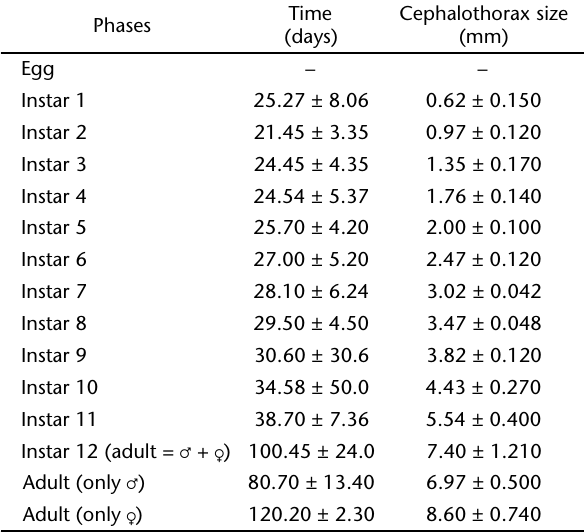
Table I. Characterization of the instars from birth to adulthood (instar 12), showing the average duration and the average size of the cephalothorax (mm) for each development phase. Values shown as X ± SD (mean ± standard deviation). For each instar, N follows the same numbers as in Table II (see ax).